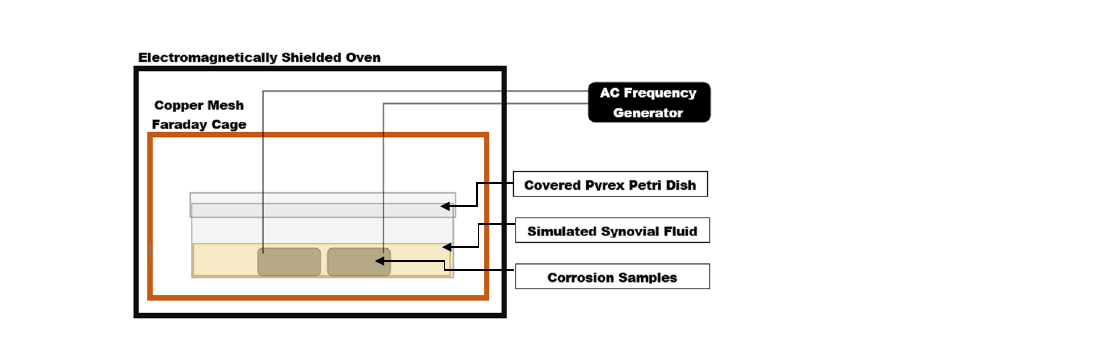
Figure 1. Schematic of corrosion experimental